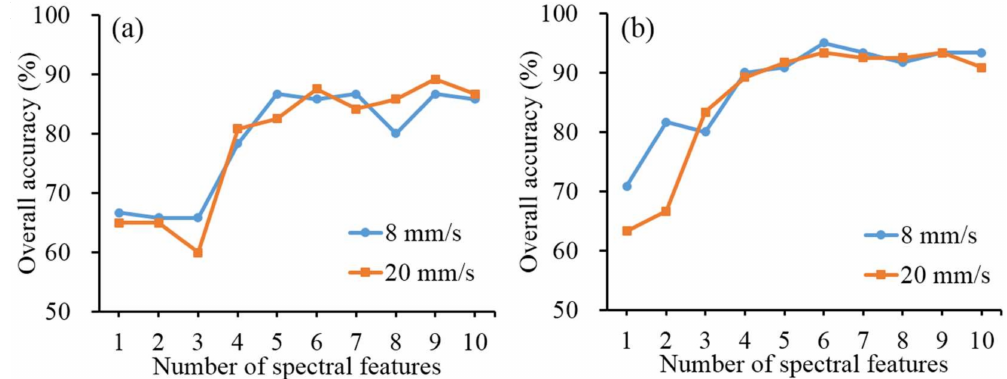
Figure 7. There-class performance comparison based on spectral features at different scanning speeds and spectral resolutions of 1.25 nm ( a ) and 5.03 nm ( b ), respectively.